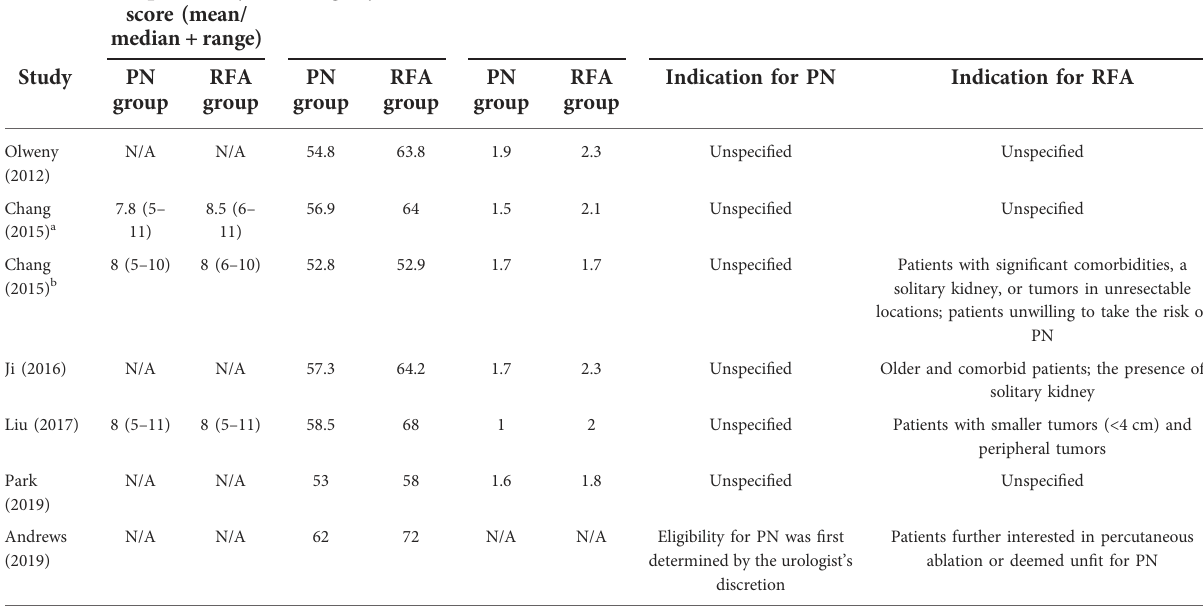
TABLE 2 Comparison of PN and RFA